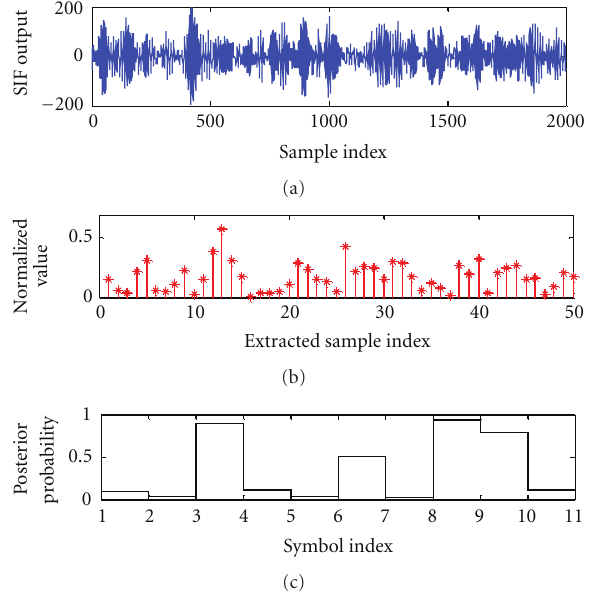
Figure 7: The waveform of SIF output and the posterior probability output obtained by SVM at SNR = − 9